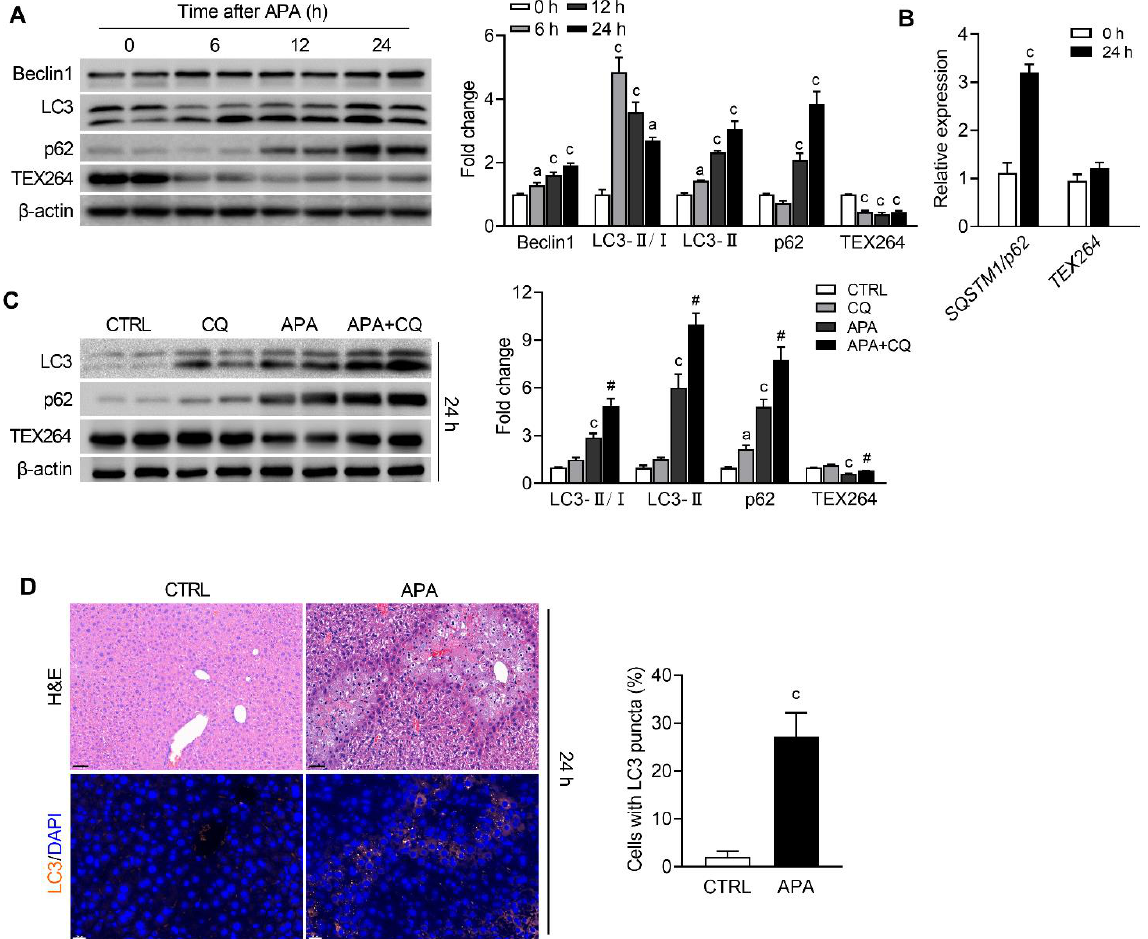
Figure 3. An APA overdose induces TEX264-mediated ER-phagy. Mice were injected with PBS or APA (300 mg/kg), and liver tissues were harvested for analysis at 6, 12 and 24 h after APA overdose. ( A ) Immunoblot analysis for Beclin1, LC3, p62, TEX264, and the corresponding densitometry normalized to β -actin. ( B ) Real-time RT-PCR was performed on mice treated with PBS or APA for 24 h. The mRNA expression of SQSTM1 / p62 and TEX264 (6–8 mice per group). ( C ) Mice were injected with CQ (60 mg/kg) 6 and 18 h after APA, and the liver tissues were collected at 24 h post-APA. Immunoblot analysis for LC3, p62, TEX264 and the corresponding densitometry normalized to β -actin. ( D ) Representative images of hematoxylin–eosin (H&E) staining (upper panel, scale bar = 50 µ m), and immunofluorescence staining for LC3 (orange; co-stained with DAPI, blue) (lower panel, scale bar = 20 µ m) at 24 h following the APA overdose. Data are presented as the mean ± SEM. a: p < 0.05 and c: p < 0.001 compared with the vehicle control. # p < 0.05 compared with the corresponding APA-treated